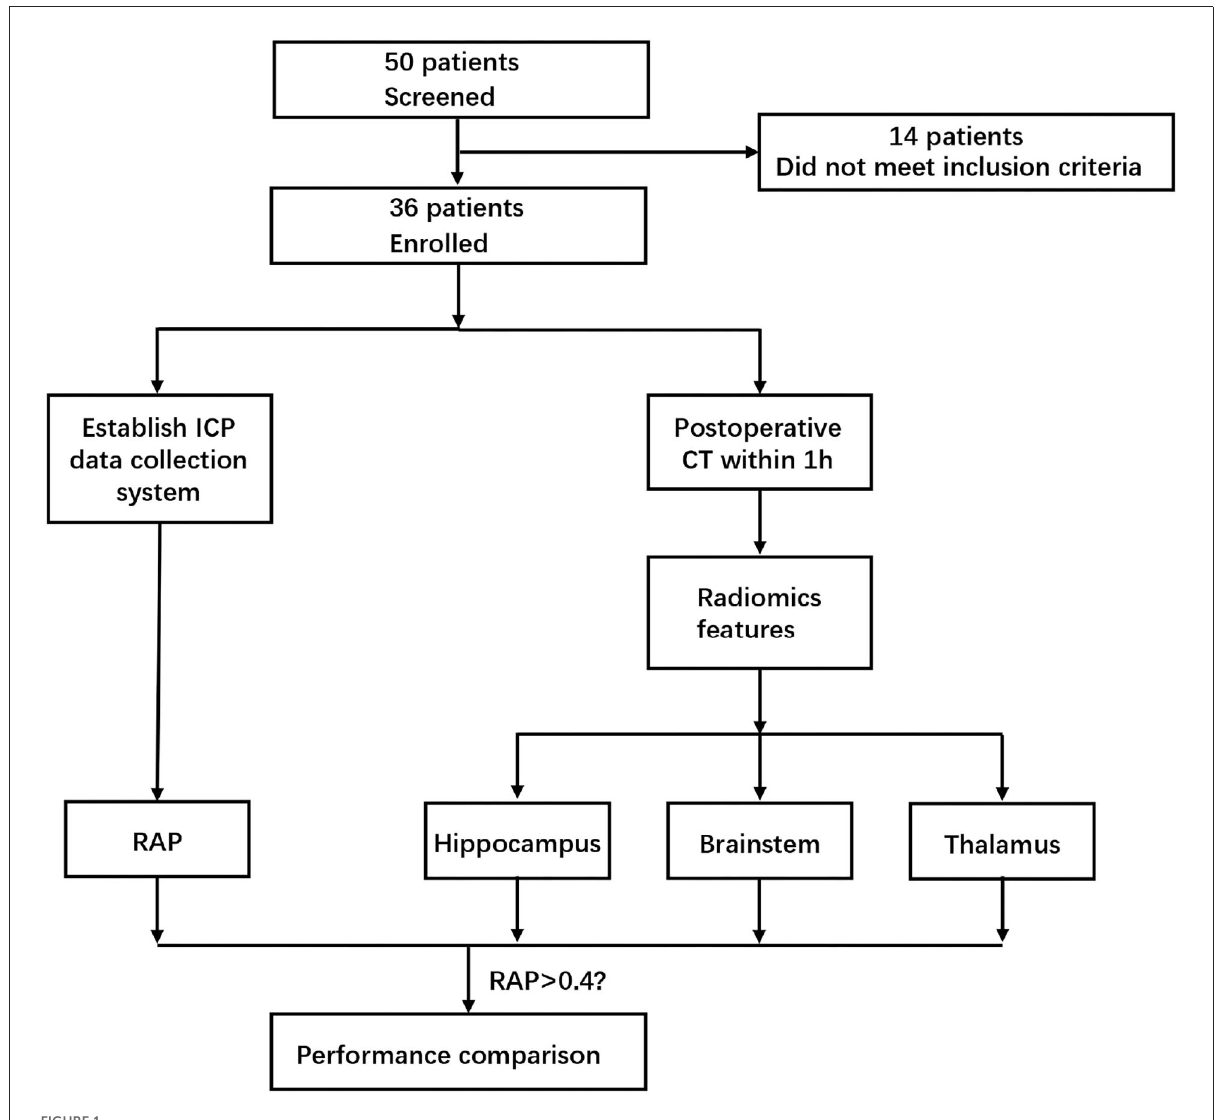
FIGURE1 Case collection and data analysis